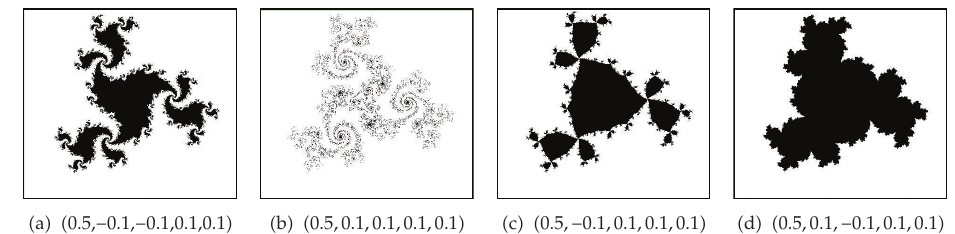
Figure 21: The generalized J sets perturbed by the composing noise when α (cid:6) 3 and c (cid:6) − 0 . 5 (cid:5) 0 . 5 i .